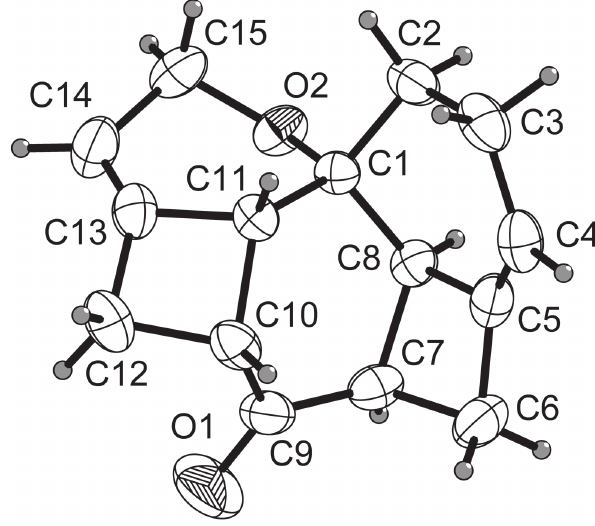
Table 1: Data collection and handling.